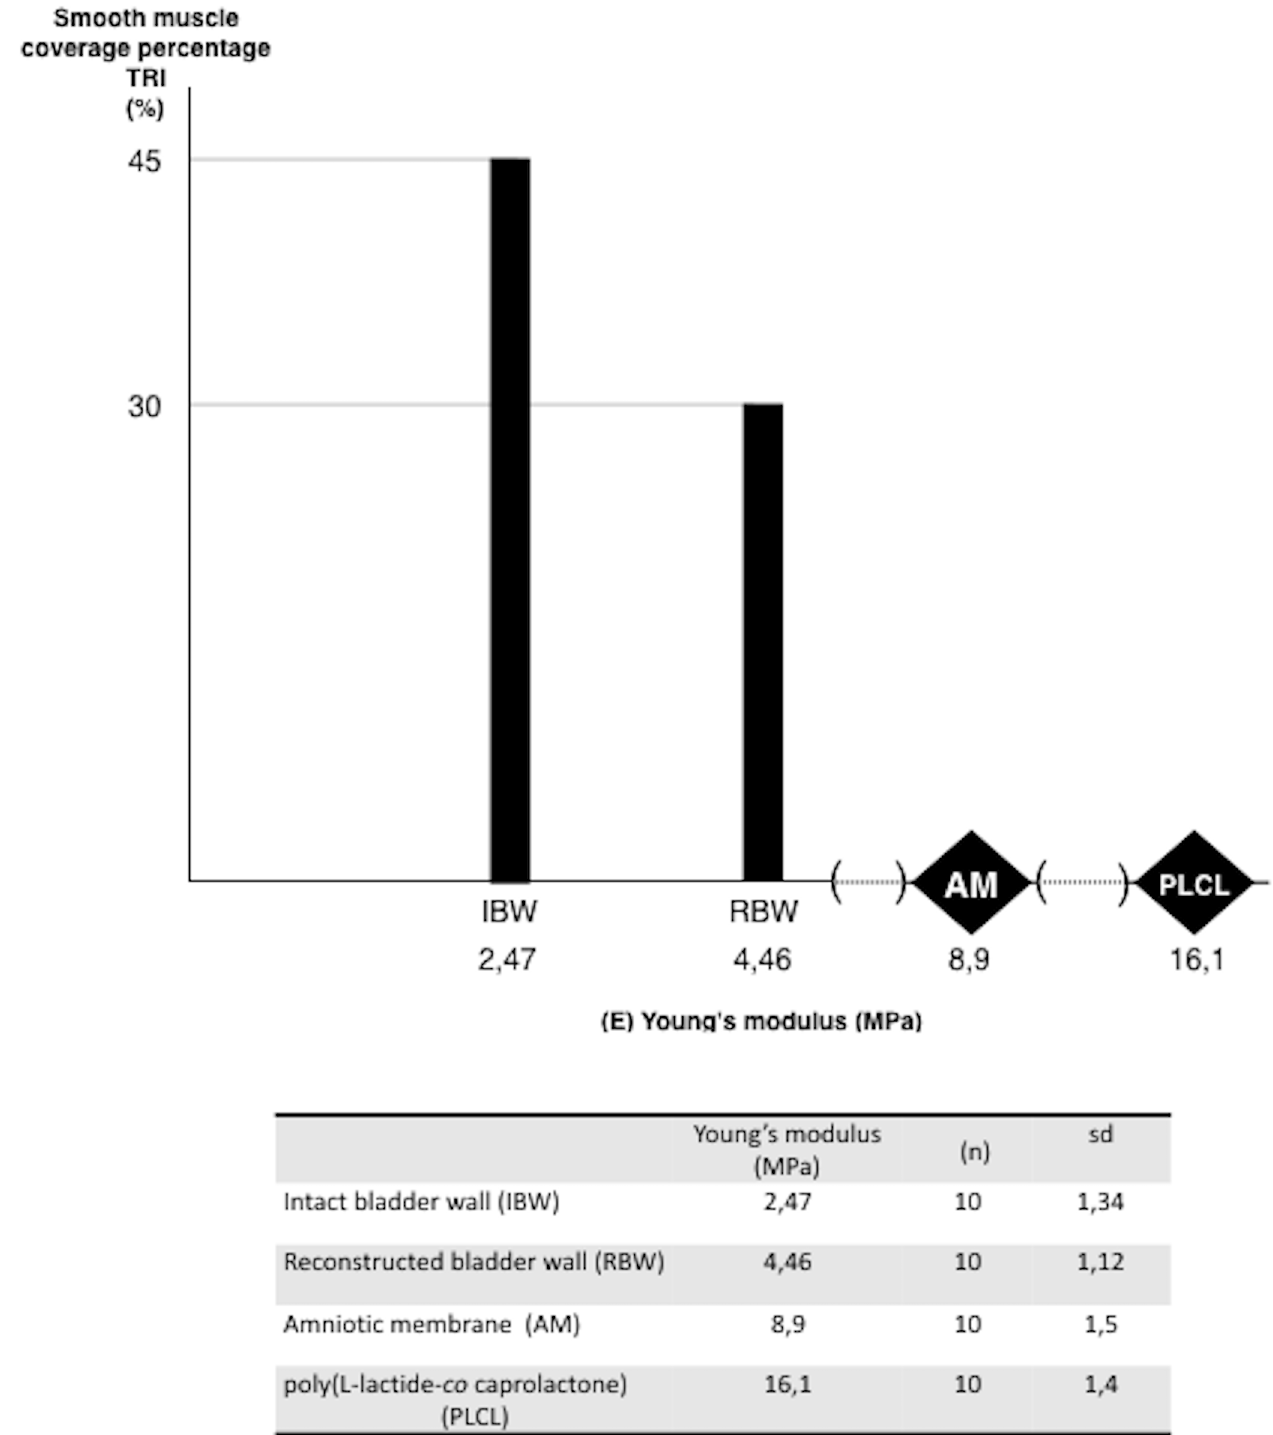
Fig 8. The mechanical evaluation of reconstructed bladder wall based on Young ’ s elastic modulus. Young ’ s modulus of intact and reconstructed bladder walls were compared to the digitally estimated content of smooth muscle content based on TRI staining average. Additionally, to reflect changes in the remodeling of the augmented bladder wall, Young ’ s modulus of Am and PLCL are presented. The presented values of smooth muscle content was rounded